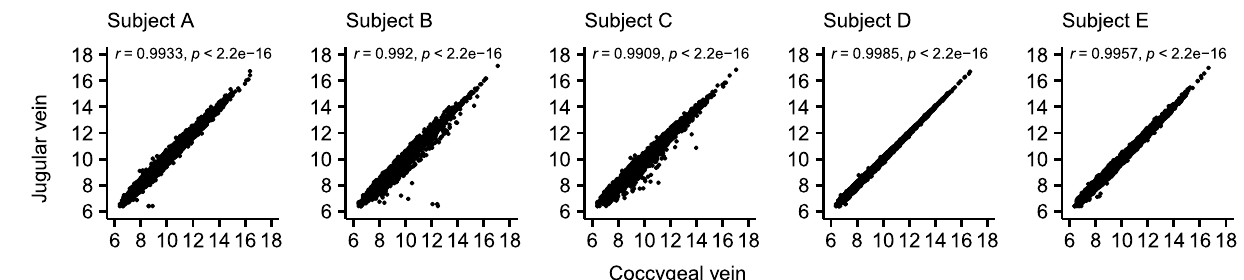
Figure 2. Transcript abundances obtained from the jugular and coccygeal veins from different subjects. The values presented are variance stabilizing read counts obtained from the “DESeq2” package 55